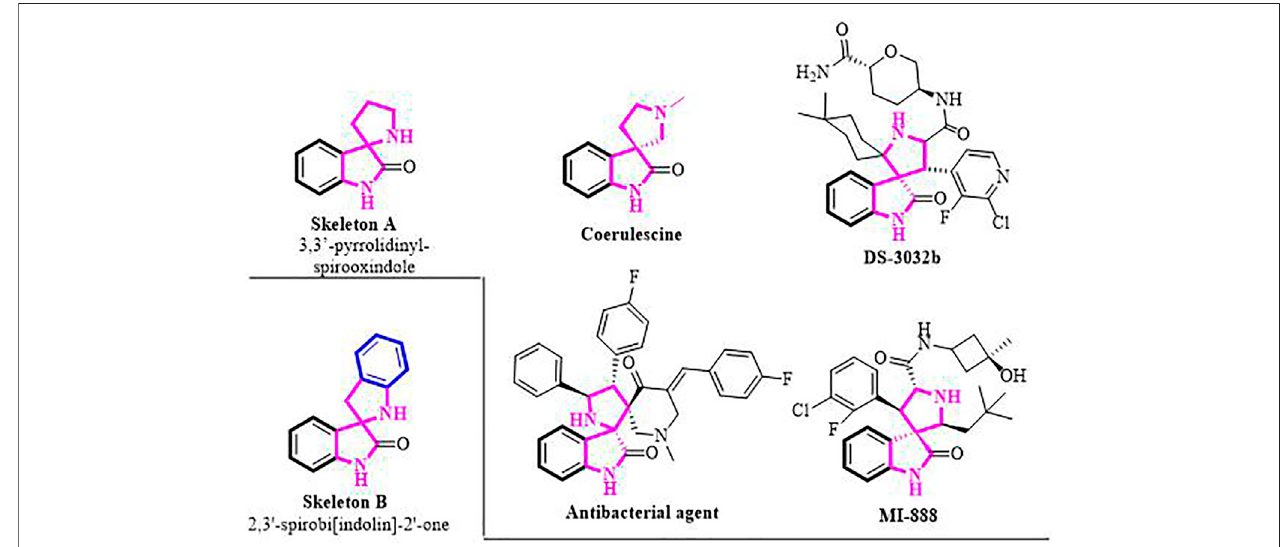
FIGURE 1 | Representative biologically active 3,3 ′ -pyrrolidinyl-spirooxindoles.